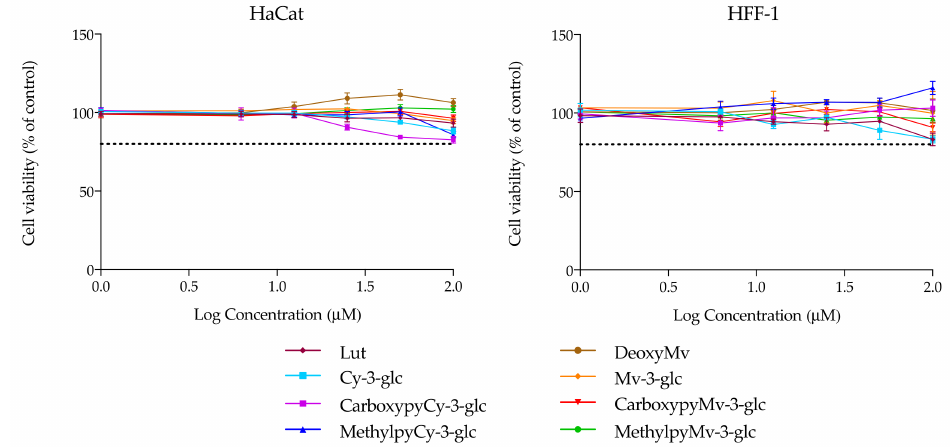
Figure 4. Cell viability of HaCat and HFF-1 cell lines in the presence of increasing concentrations of the compounds, evaluated by MTT assay. Dotted lines represent 80% viability.